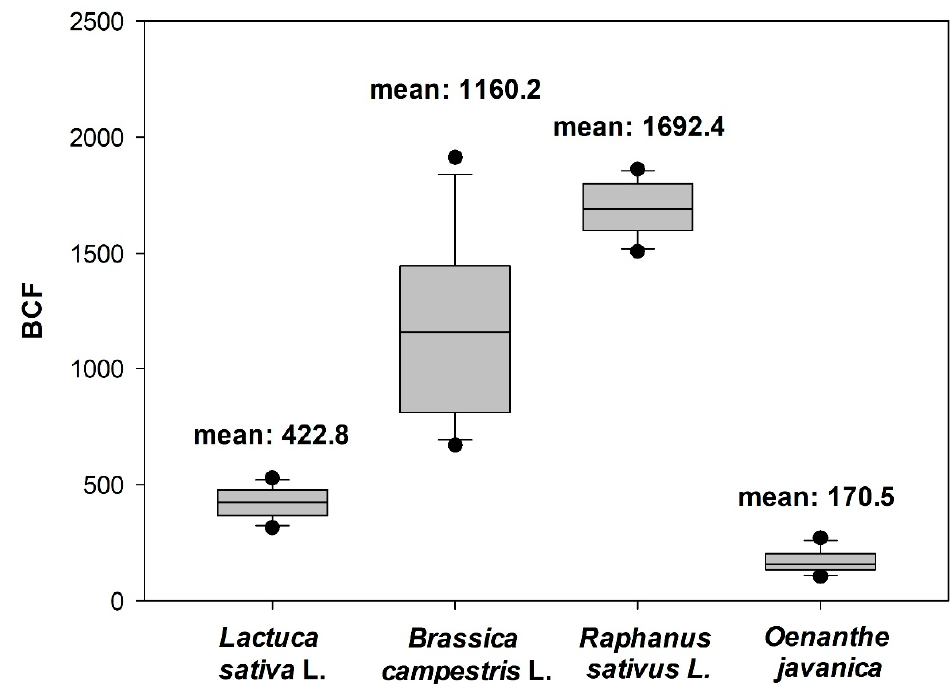
Figure 4. Box-and-whisker plot of bioaccumulation factors of four plant species in genuine groundwater samples with different initial uranium concentrations (83 and 173 μ g/L) after 72 h of treatment.